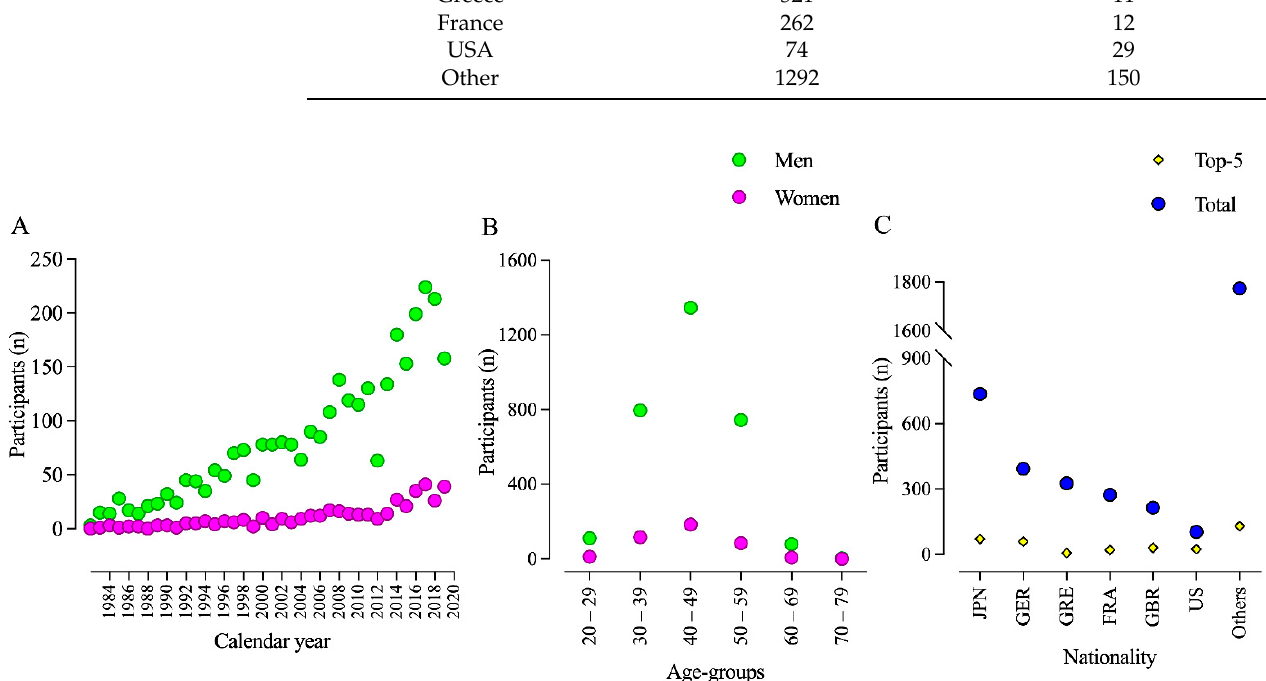
Figure 1. Participation trends in the Spartathlon by calendar year ( A ), age groups ( B ), and nationality ( C ).